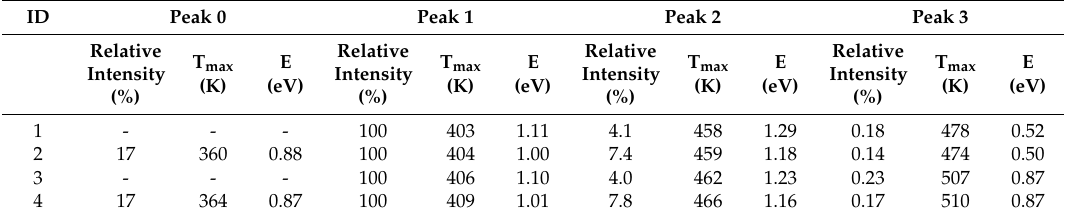
Table 2. Parameters of individual TL peaks of LSO:Ce and YSO:Ce SCFs obtained after deconvolution. Relative intensity shows the intensity of a particular peak with respect to peak with maximum